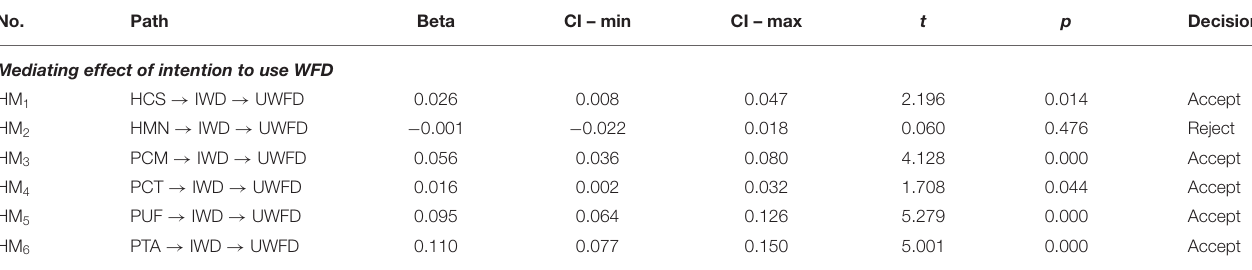
TABLE 4 | Mediating effect.